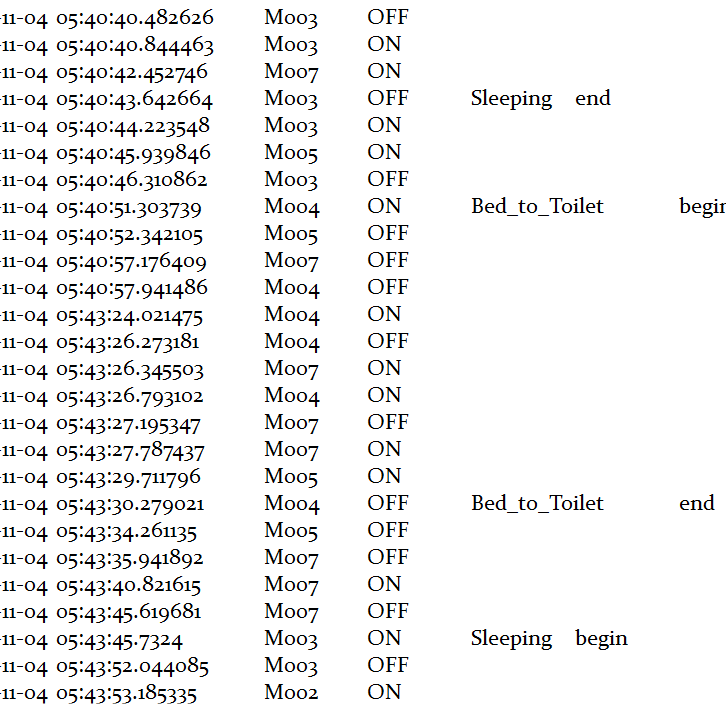
Figure 9. An extract of Aruba dataset with raw data. For reasons of software development, the motion sensors and door sensors with “SensorValue” of “ON/OPEN” and “OFF/CLOSE” are mapped to “1” and “0”, respectively. “Date” is converted from the form of “yyyy-mm-dd H:M:S” to epoch time in milliseconds relative to the zero hour of the current